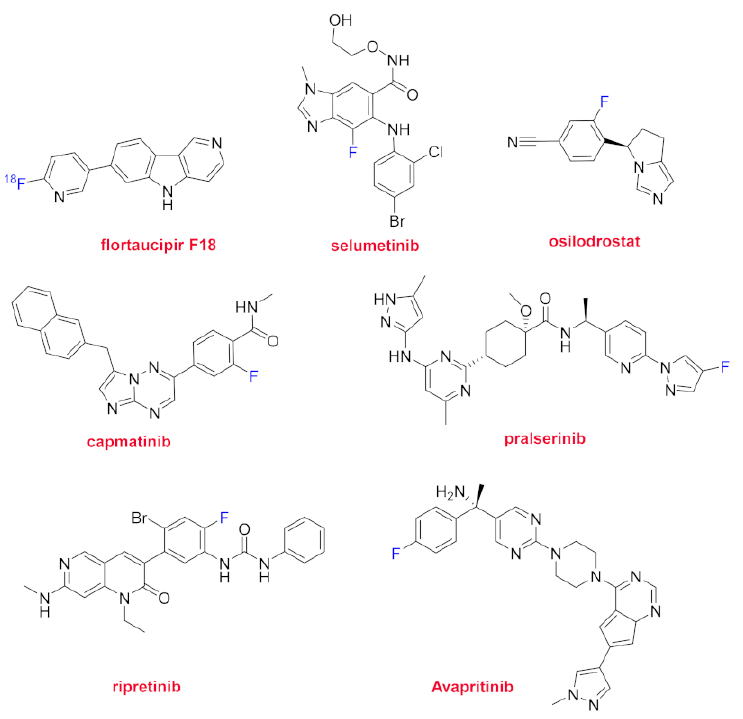
Figure 11. Structure of drugs containing one fluoroaryl moiety (fluorine atoms shown in